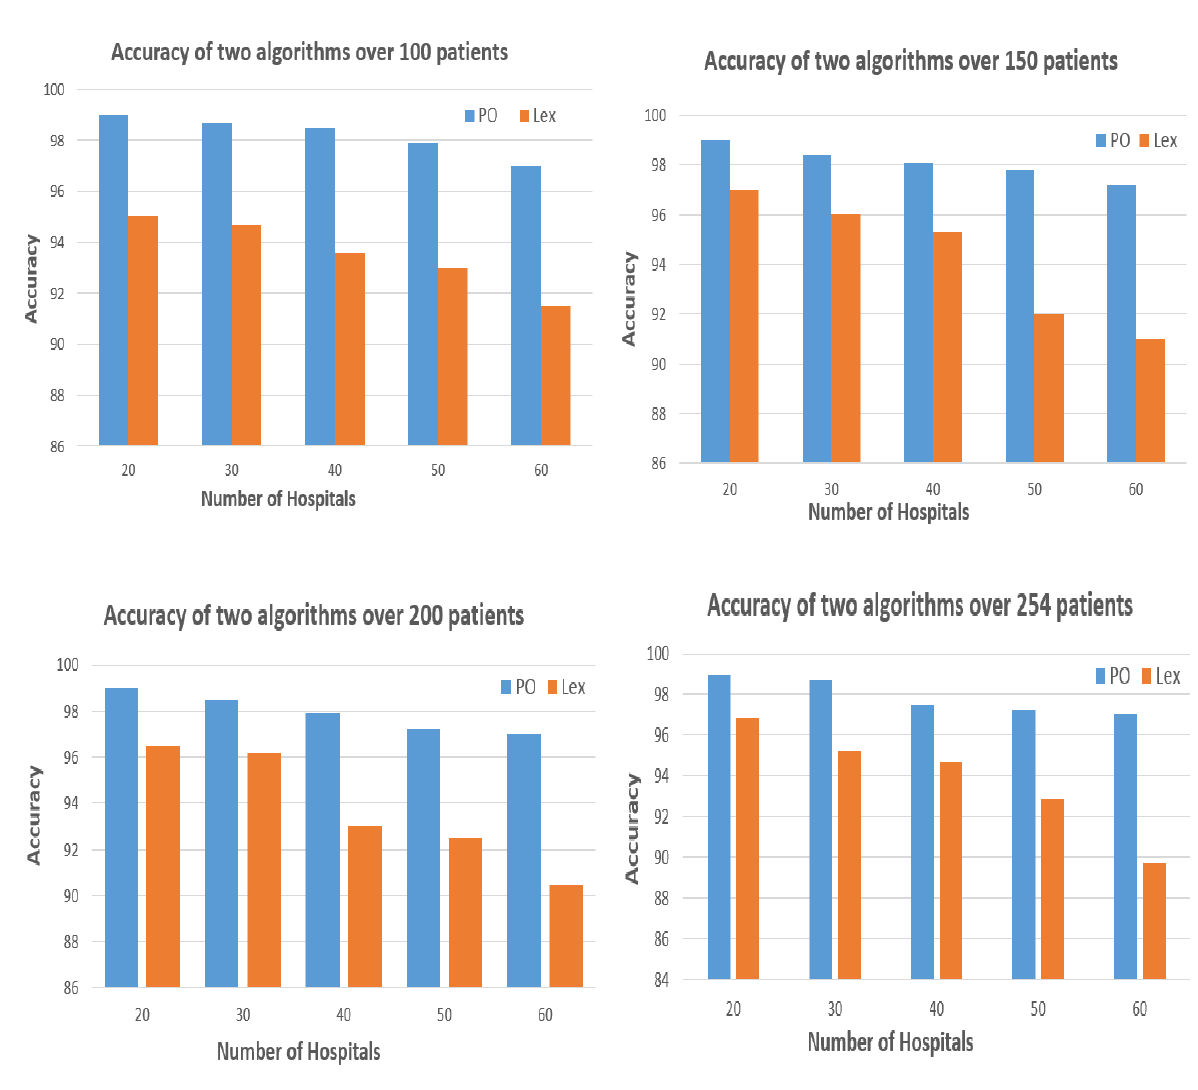
Figure 4. Comparisons between Pareto optimization and lexicographic algorithms according to accuracy over a different number of patients and